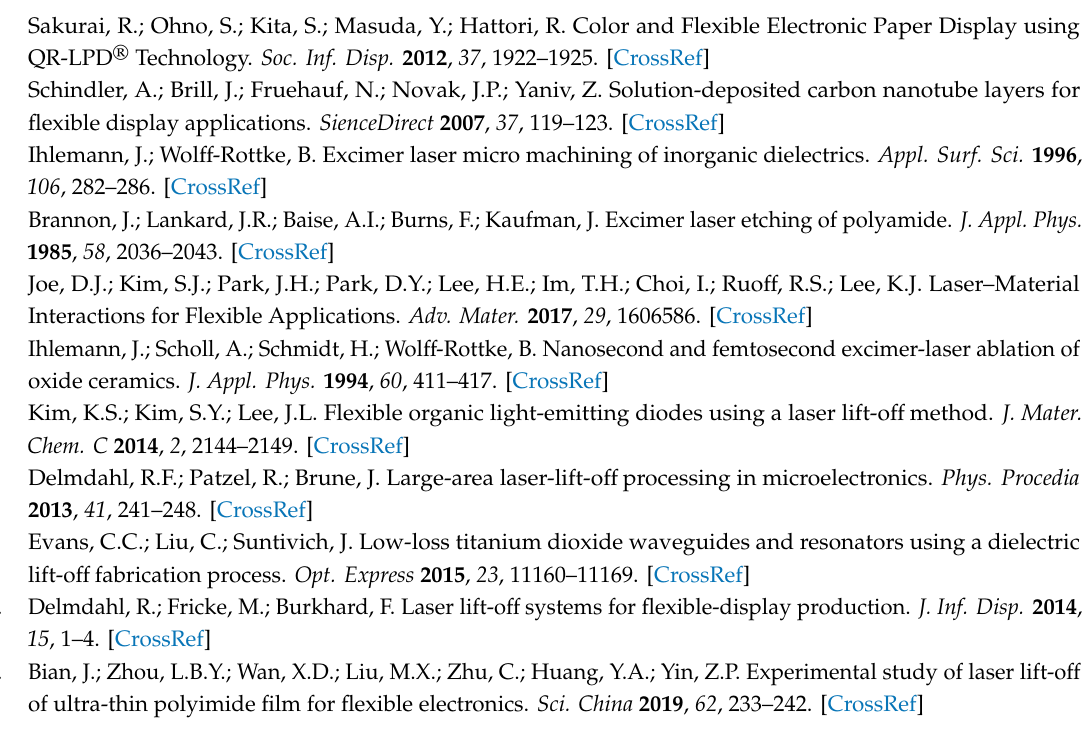
Figure S1. Measured and calculated spectra of transmittance, reflectance and absorption of LTHC